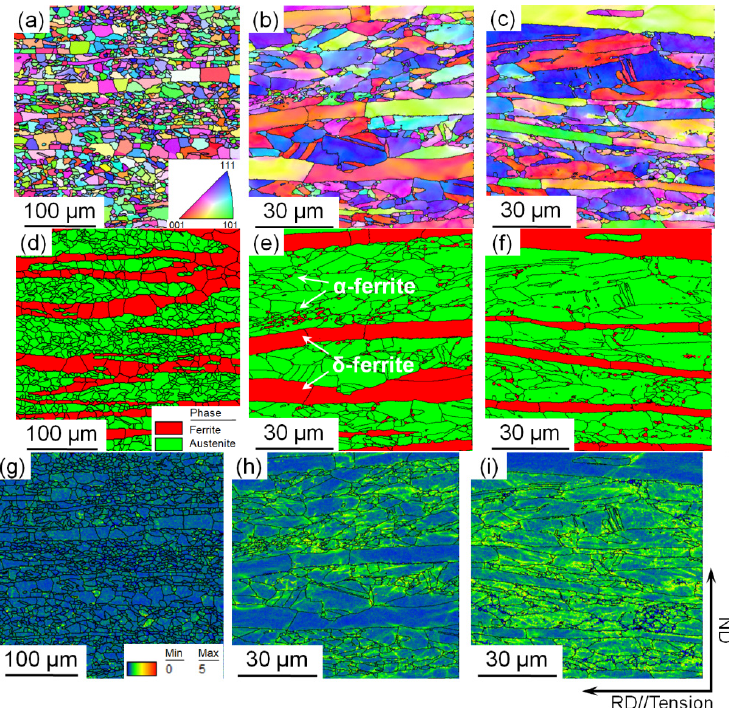
Figure 4. EBSD ( a – c ) inverse pole figures, ( b – f ) phase map and ( g – i ) kernel average misorientation of the samples annealed at 800 °C and stretched to strains of ( a , d , g ) 0, ( b , e , h ) 0.15 and ( c , f , i ) 0.3.